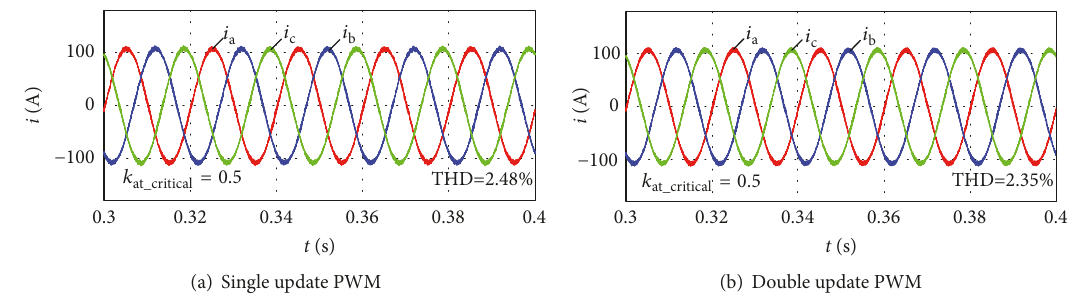
Figure 14: Steady state simulation waveforms of grid currents with 𝑘